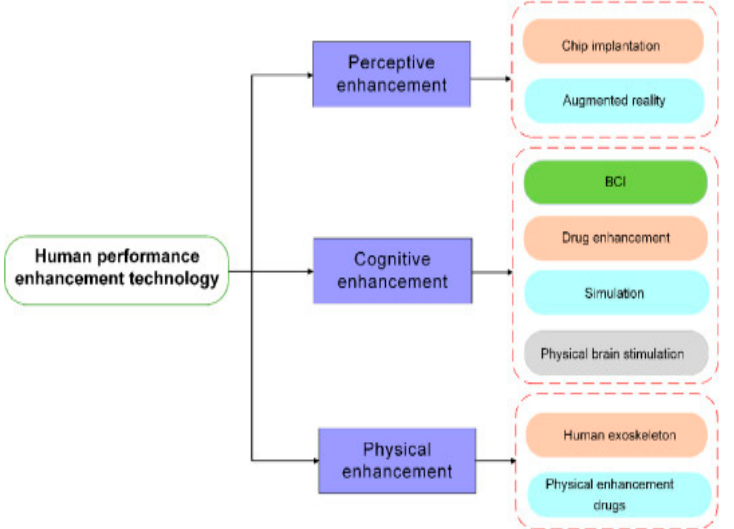
Figure 9. The delineation between human performance optimization and human performance enhancement is outcome-based [50].